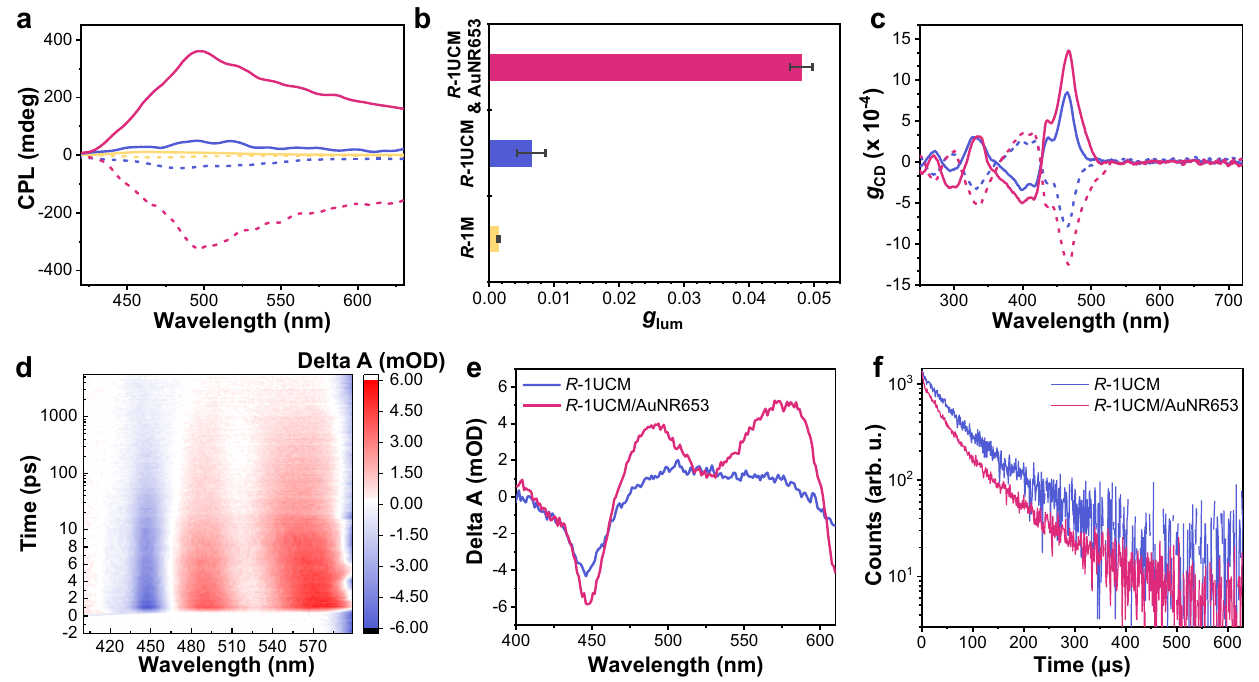
Fig.3|Chiropticalpropertiesofplasmon-micellecomposites.a CPLspectraof R − 1M (yellow line) and S − 1M (yellow dash line) in water excited by 400nm. UC-CPL spectra of R − 1UCM (blue line), S − 1UCM (blue dash line), R − 1UCM/AuNR653 (red line), and S − 1UCM/AuNR653 (red dash line) in deaerated water excited by 635nm laser. b Dissymmetryfactor g lum valuesofCPL,UC-CPL,andplasmon-enhancedUC- CPLatpeakvaluesofemission.Allerrorbarsshowmean±standarddeviation. n =3 independent experiments. c CD dissymmetry factor g CD of R -1M (blue line), S -1M (bluedashline), R -1M/AuNR653(redline),and S